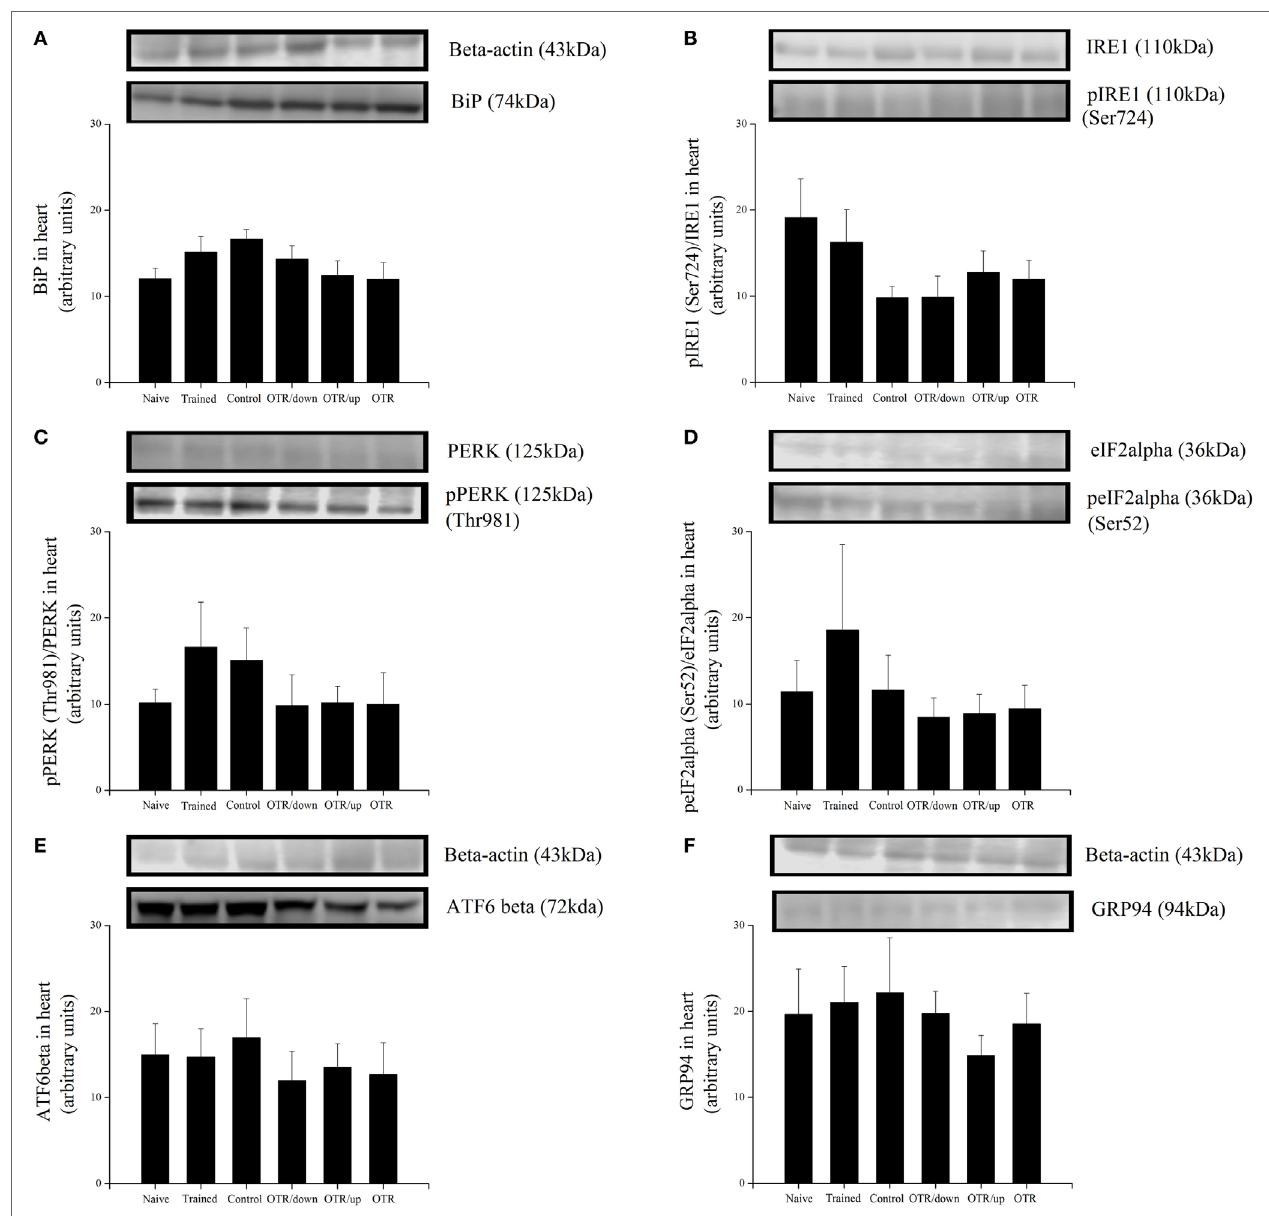
FigUre 4 | Protein levels (arbitrary units) of BiP (a) , pIRE1 (Ser724)/inositol-requiring enzyme 1 (IRE1) (b) , pPERK (Thr981)/protein kinase RNA-like endoplasmic reticulum kinase (PERK) (c) , peIF2alpha (Ser52)/eIF2alpha (D) , ATF6beta (e) , and glucose-regulated protein 94 (GRP94) (F) in the hearts of experimental animals. Data are expressed as the mean ± SE of n = 8 mice. N, sedentary mice; TR, trained mice; CT, sedentary mice; OTR/down, overtrained by downhill running; OTR/ up, overtrained by uphill running; OTR, overtrained by running without inclination. The original experiments are available in supplementary file 9 (i.e., ATF6beta), file 10 (i.e., PERK), file 11 (i.e., Bip, pIRE1, and IRE1), files 12a.b and 12c.d (i.e., peIF2alpha, eIF2alpha and GRP94), and file 15 (i.e.,